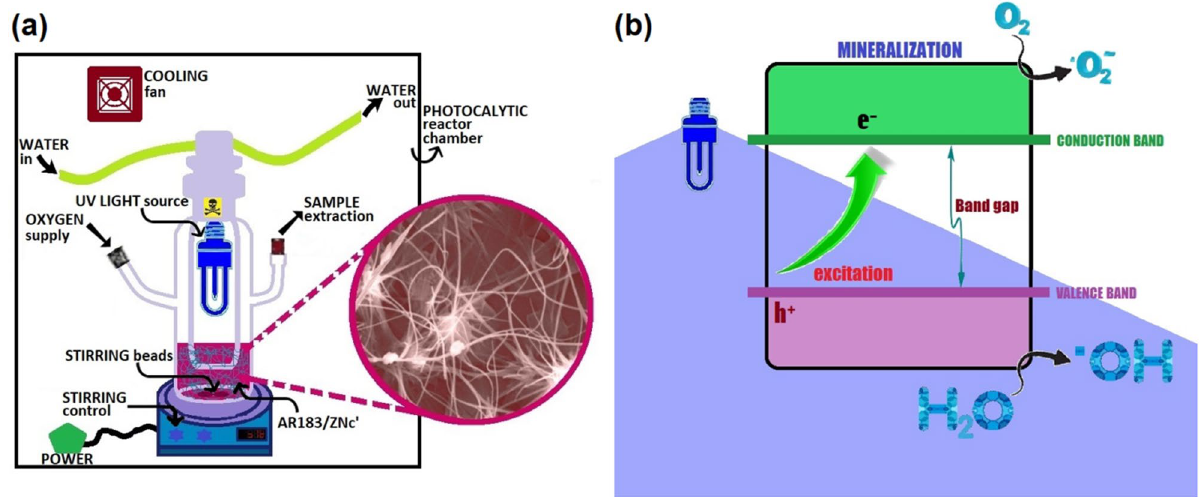
Figure 6. ( a ) UV-Photoreactor with Azo Dye AR183 & photocatalyst ZNsw and ( b ) Schematic representation of photocatalysis mechanism used with Azo Dye AR183.